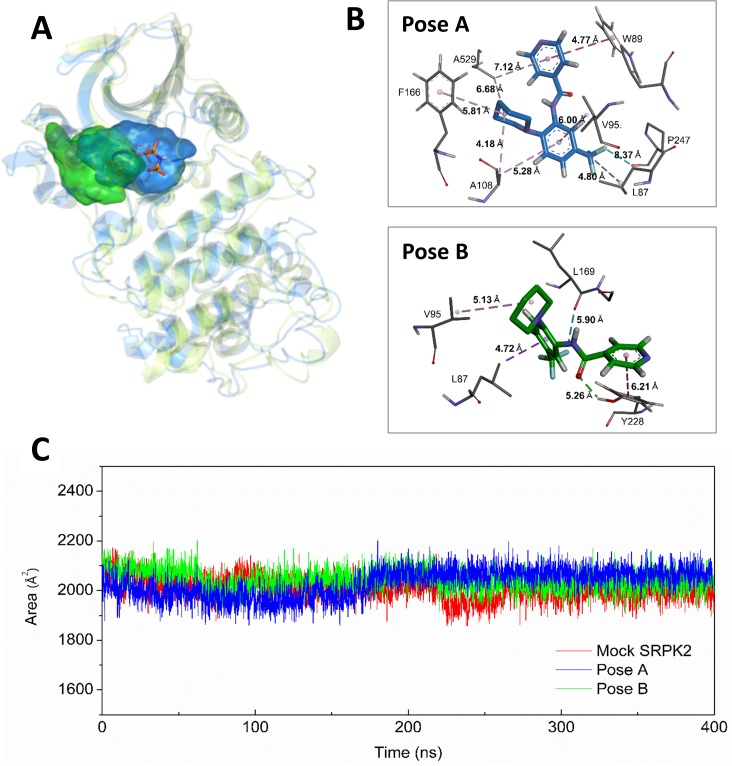
Molecular Dynamic Analysis.(A) Occupied space of SRPIN340 during simulations from poses A (blue) and B (green). Average protein structures are shown superposed in light blue for simulation A and in light green for simulation B. The ATP analogue ANP (shown in orange sticks) occupies the same region as SRPIN340 during both simulations. (B) Snapshot from pose A (upper) and pose B (bottom) simulations highlighting the possible SRPIN340 (orange sticks) interaction network. (C) Solvent accessible surface area (SASA) for tryptophan residues in the presence of the ligand, blue and green for poses A and B, respectively. The pose A simulation shows a signal increase at 175 ns, indicating a major exposure of residues to the polar solvent from this point of simulation. This is in agreement with the fluorescence spectroscopy analysis shown in Fig 6.